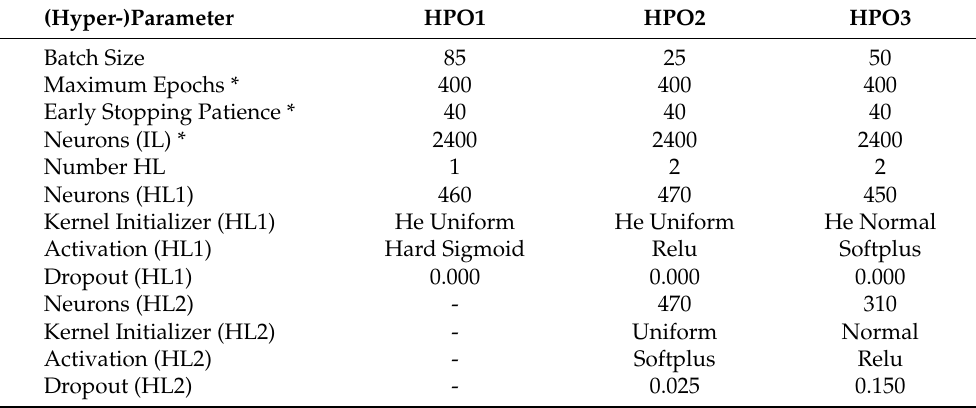
Table A6. Neural Net settings from hyperparameter optimization (* = default